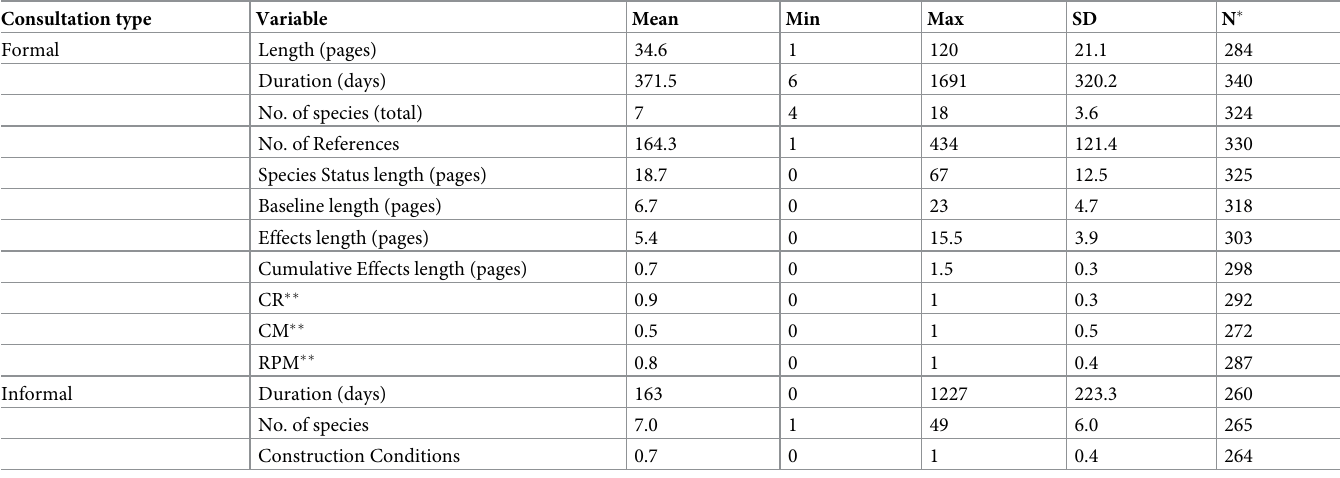
Table 2. Summary statistics across all 123 formal and informal consultations.